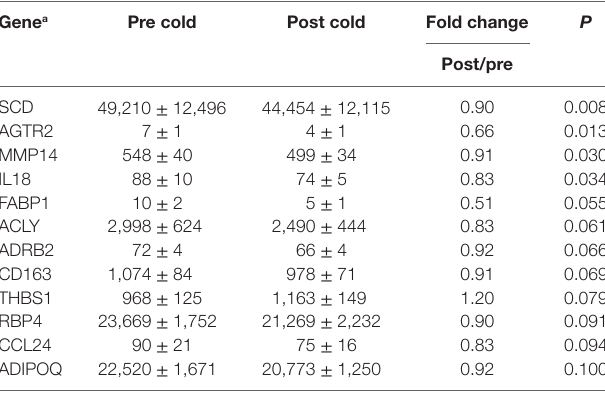
( Table 3 ). These included PPAR α , PGC1 α , HSL, and ANGPTL4 ( Table 3 ). Adipose triglyceride lipase (PNPLA2) and the coacti- vator of ATGL (CGI-58; ABHD5) showed a trend for induction ( Table 3 ). VEGF, which stimulates angiogenesis and beiging (14), was also induced by icing ( Table 3 ). Despite the TaBlE 2 | Gene expression changed by cold before KDT501 treatment.